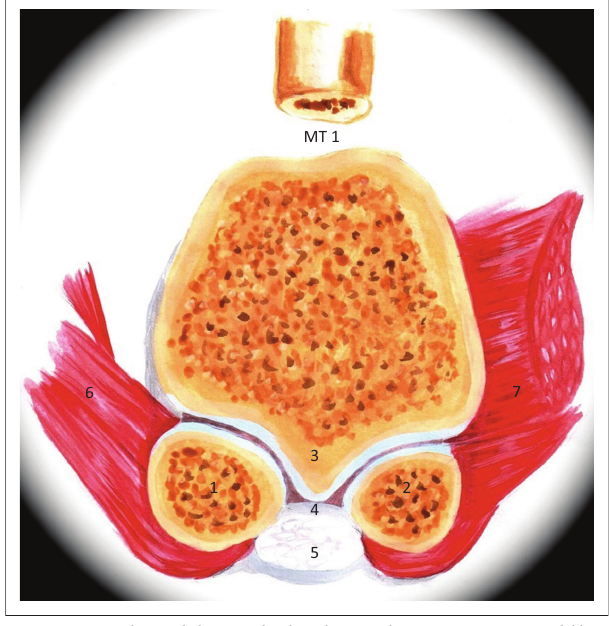
FIGURE 4: Schematic diagram of the anatomy of the first metatarsophalangeal sesamoid complex in the short axis view.